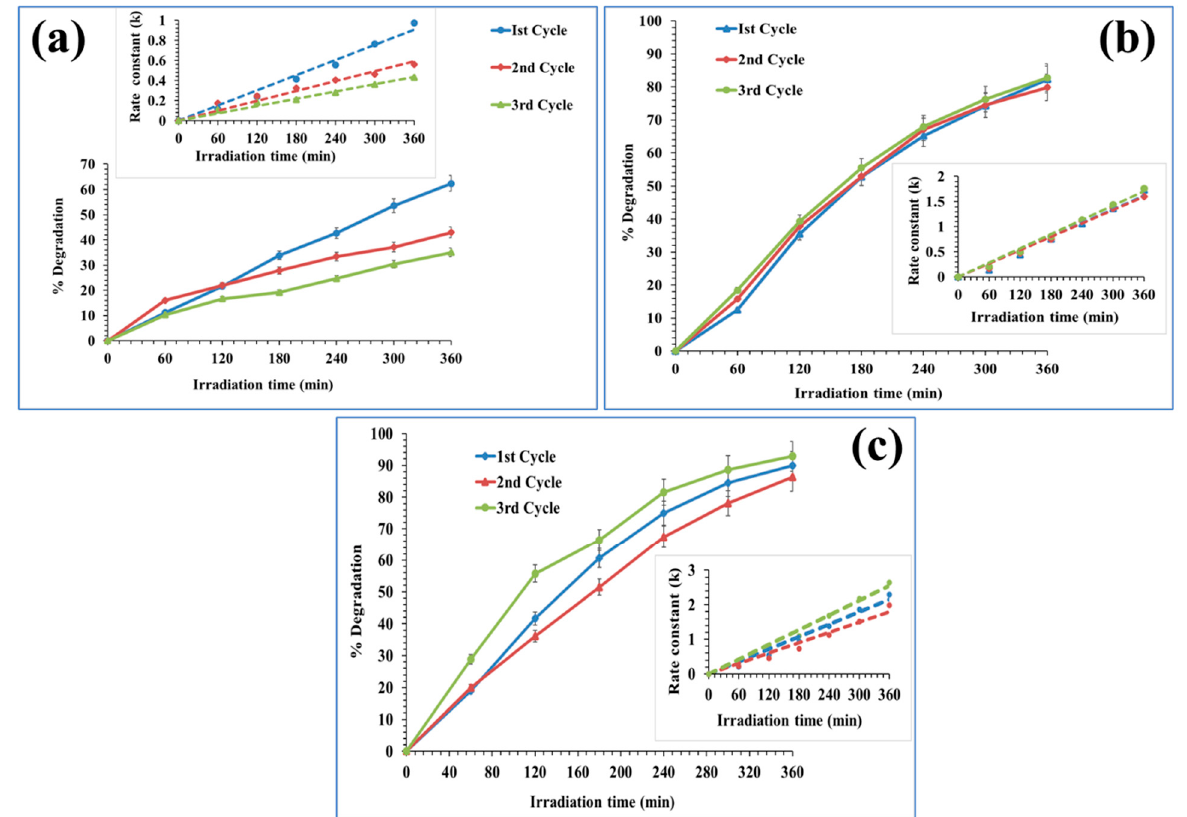
Figure 17. Photocatalytic degradation performance efficiency and inset photocatalytic degradation rate constant (k) of ~5 mg Mo/HRTiO 2 ceramic supported photocatalyst over 50 mg/L initial IBU concentration under natural (unmodified) pH ~ 4 and 365 nm UV irradiation with ( a ) single disk tablet, ( b ) double disk tablet, and ( c ) triple disk tablet numbers.